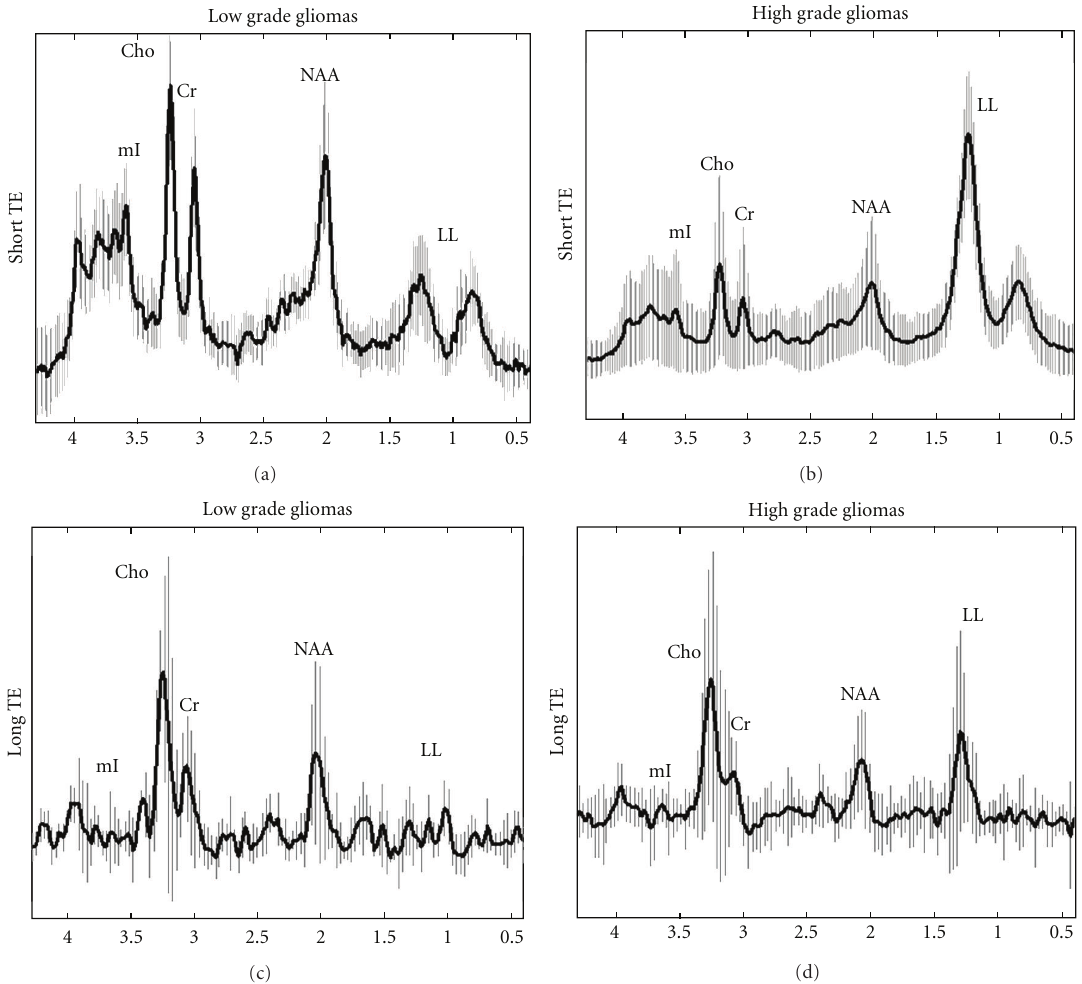
Figure 2: In vivo short TE ((a), (b)) and long TE ((c), (d)) mean spectra with their corresponding standard deviations (vertical lines) from the intratumoral area of low grade ((a), (c)) and high grade gliomas ((b), (d)). decrease with glioma grade [33]. It is well known that ele- vation of mI may occur either by rapid cellular proliferation or cellular distraction and gliosis from irradiation